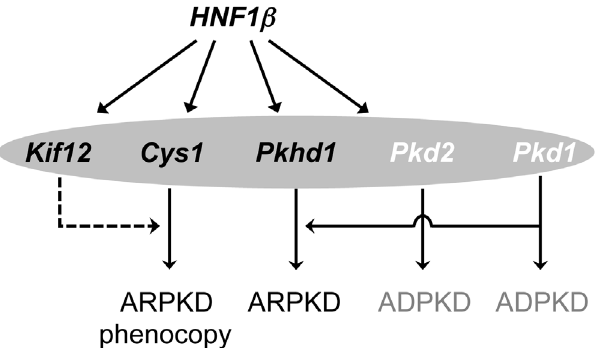
Fig 6. Proposed integration of Kif12 into recessive PKD genetic pathway. Hnf1 β regulates the transcription of several cystogenic genes including Pkhd1 , the mouse orthologue of the principal ARPKD gene; Cys1 , the gene mutated in the cpk model of ARPKD, and Kif12 , a candidate modifier of the Cys1 cpk/cpk phenotype. Therefore, we propose that the four proteins encoded by Hnf1b , Cys1 , Kif12 , and Pkhd1 may define a functional complex that modulates the progression of recessive PKD (black font). This hypothesis is supported by the very high correlations among structural and developmental expression patterns of these four genes (Fig 4). In addition, components of the recessive PKD-associated pathway may interact at different levels with functional components of ADPKD-associated pathways (white font). For example, HNF1 β also regulates the expression of Pkd2 , an ADPKD gene. Furthermore, genetic interaction studies suggest that abnormal Pkd1 expression sensitizes renal tubular cells to Pkhd1 defects [28, 29]. The latter interaction may physically occur within the primary apical cilium (shaded oval), where these proteins all co- localize. The proposed Kif12 modulating effect on Cys1 function is designated by dashed line, solid lines correspond to previously described